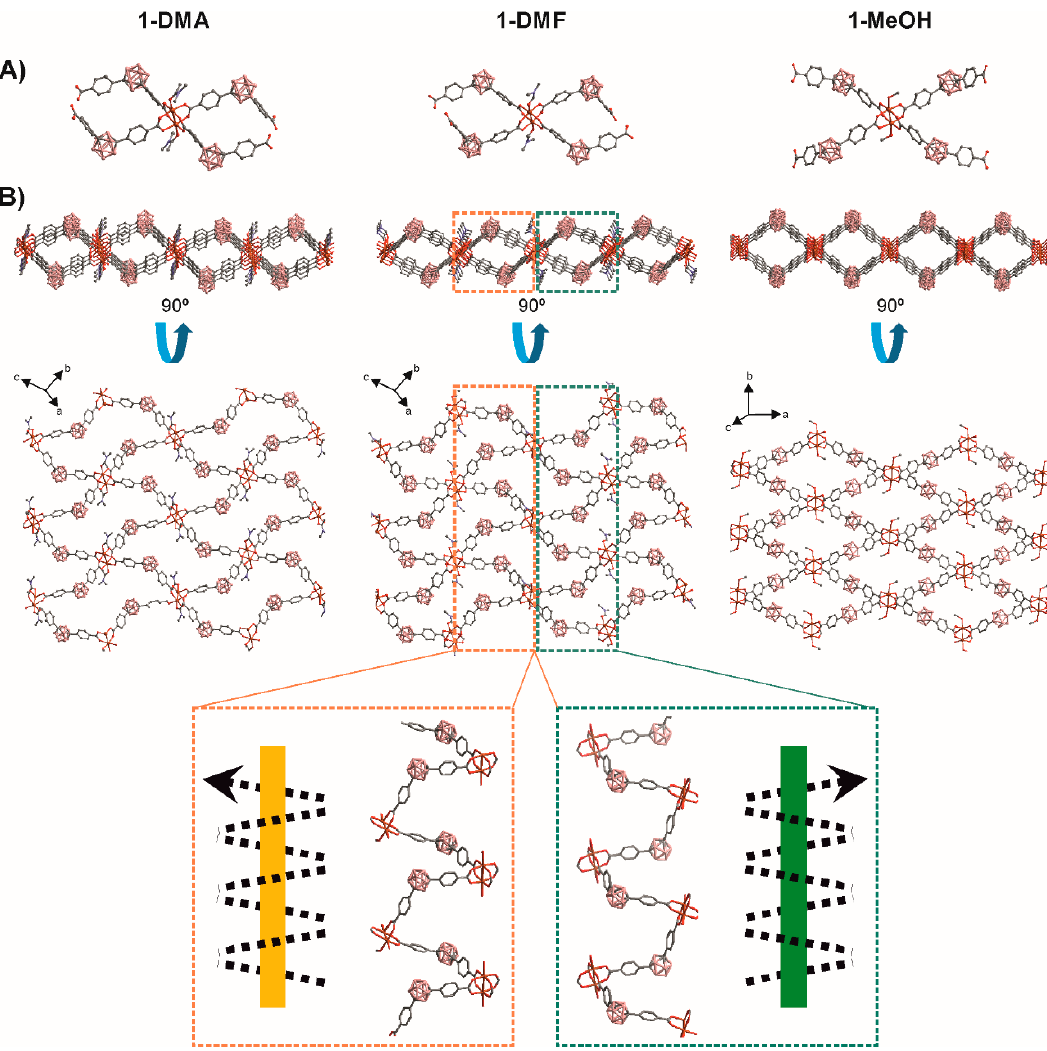
Figure 1. A comparative view of the crystal structures of 1-DMA, 1-DMF, and 1-MeOH. (a) View of the Cu2-paddlewheel units with L1 coordination. (b) Two perpendicular views of the extended structures showing the 2D 4 4 networks; 1D helical chains with right hand (green) or left hand (orange) are indicated for 1-DMF. H atoms are omitted for clarity. Color code: B pink; C grey; O red; N blue, Cu orange.